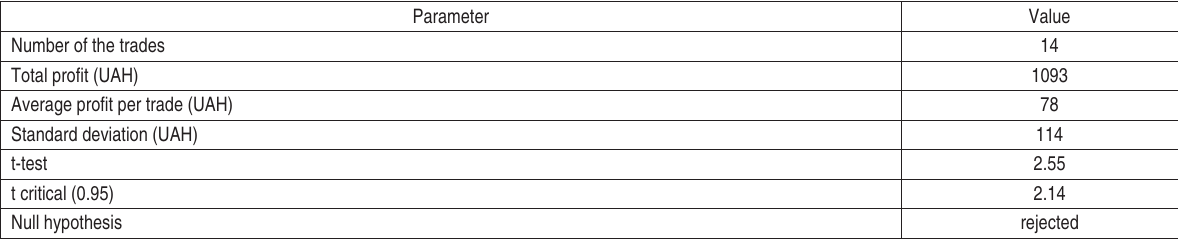
Table 8. T-test for the trading simulation results for the turn-of-the-year effect (PFTS index)